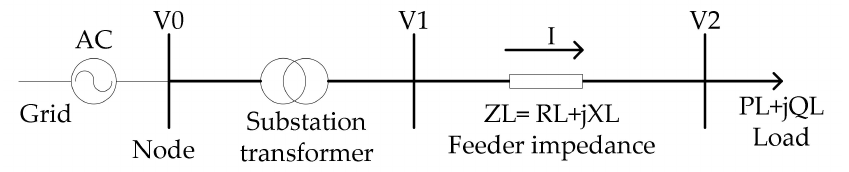
Figure 2. Single-line diagram of distribution